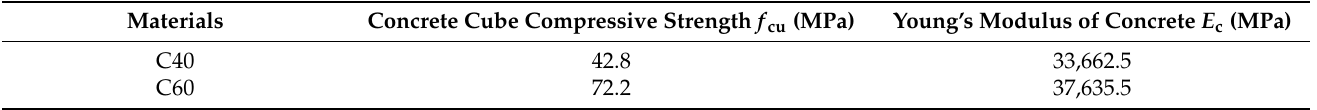
Table 2. Material properties of concrete.